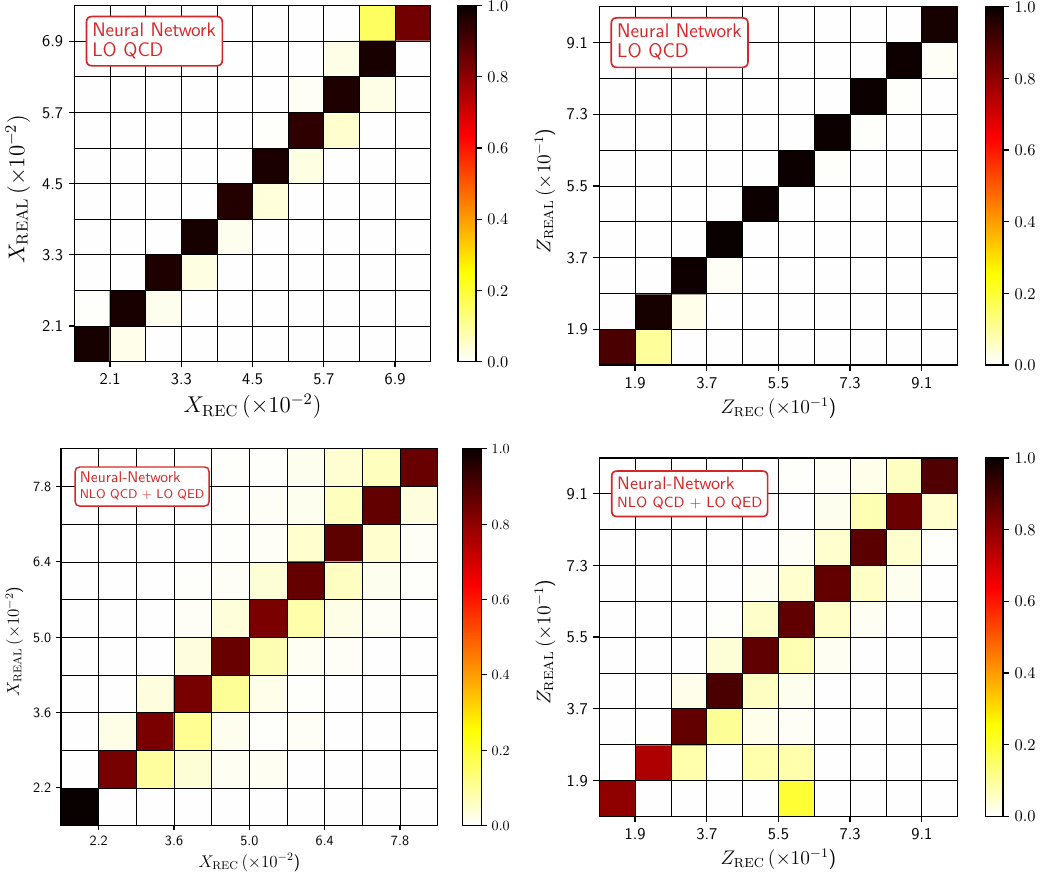
Figure 16: Left: Comparison of the momentum fractions X with MLP neural networks with the parameters given in Table 2. The upper (lower) row corresponds to the LO QCD (NLO QCD + LO QED) data set. Right: same as the l.h.s but for Z and Z REAL REC